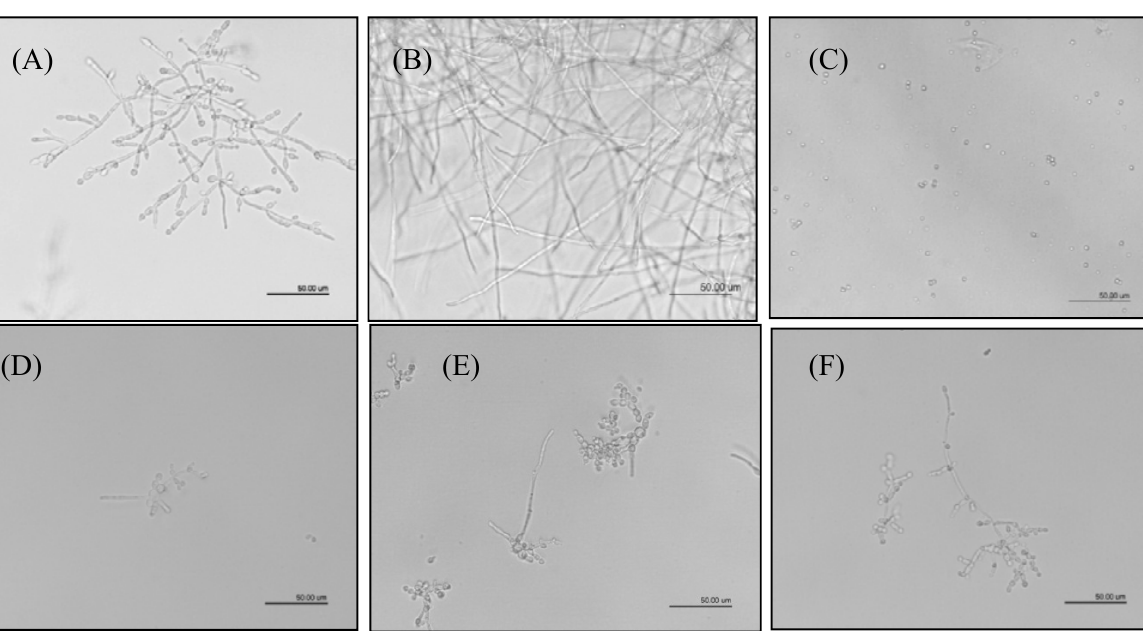
Figure 3. Hyphal formation of C. albicans NCPF 3153 cells. ( A ) 12 h normal growth; ( B ) 24 h normal growth; ( C ) C. albicans cells treated with 0.005 mg/mL anphotericin